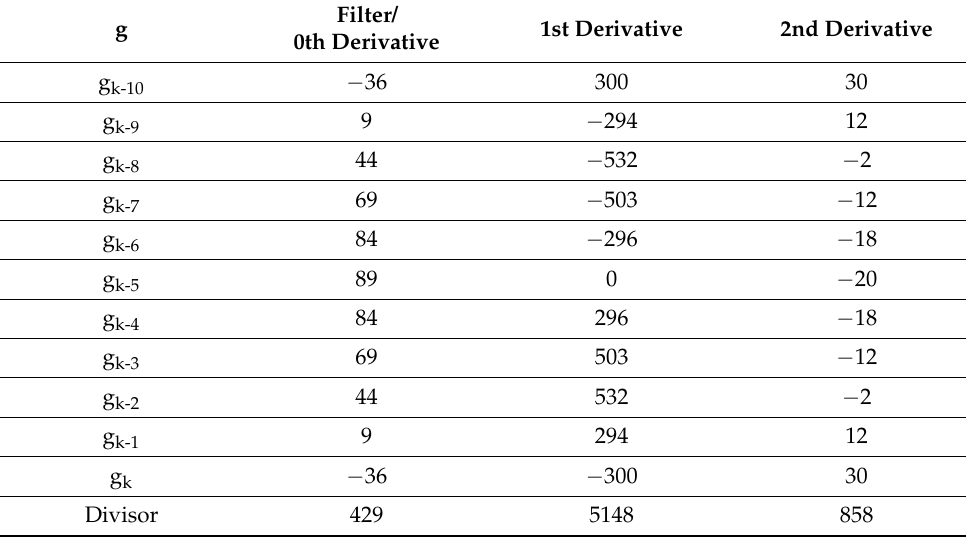
Table 1. Matrix g for 5 side points and order